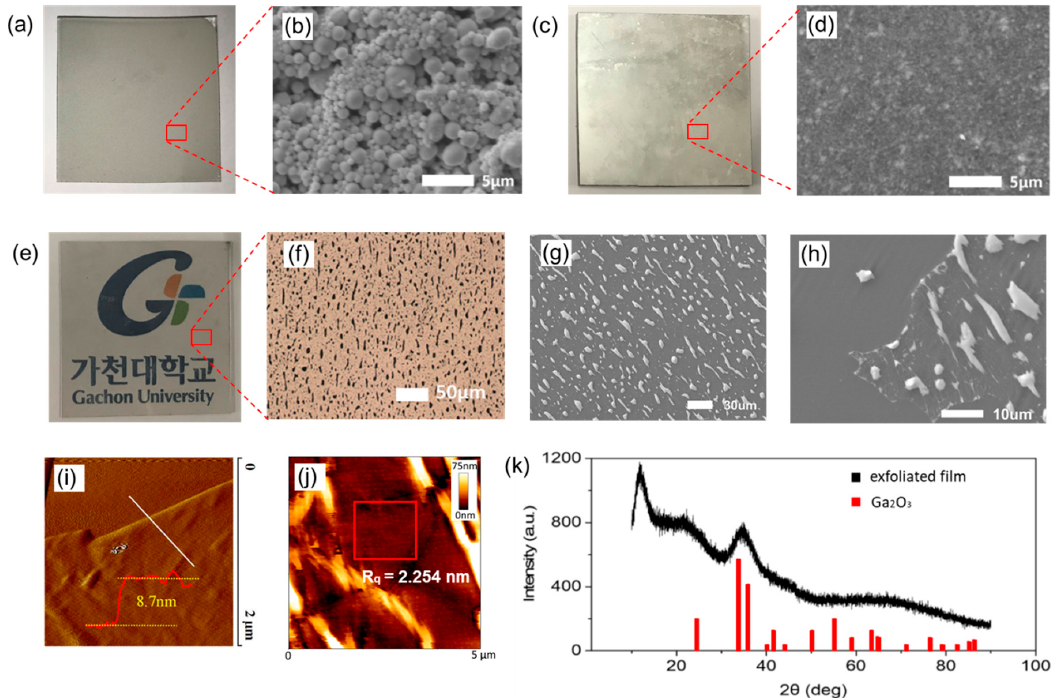
Figure 2. ( a ) Liquid metal microdroplets distributed on a PDMS substrate; ( b ) SEM image of the liquid metal (LM) microdroplets; ( c ) Image of a thin conductive LM film after peeling off process; ( d ) SEM image of the continuous conductive LM film on a PDMS substrate; ( e ) The transparent gallium oxide film attached on a PDMS after peeling off from the LM film; ( f ) Magnified optical image; ( g ) SEM image of the transparent film of ( e ); ( h ) a piece of the thin tore transparent film on a PDMS substrate; ( i ) The thickness and ( j ) the roughness of transparent gallium oxide film (boxed area) by AFM; ( k ) XRD pattern of the exfoliated film on a PDMS substrate.